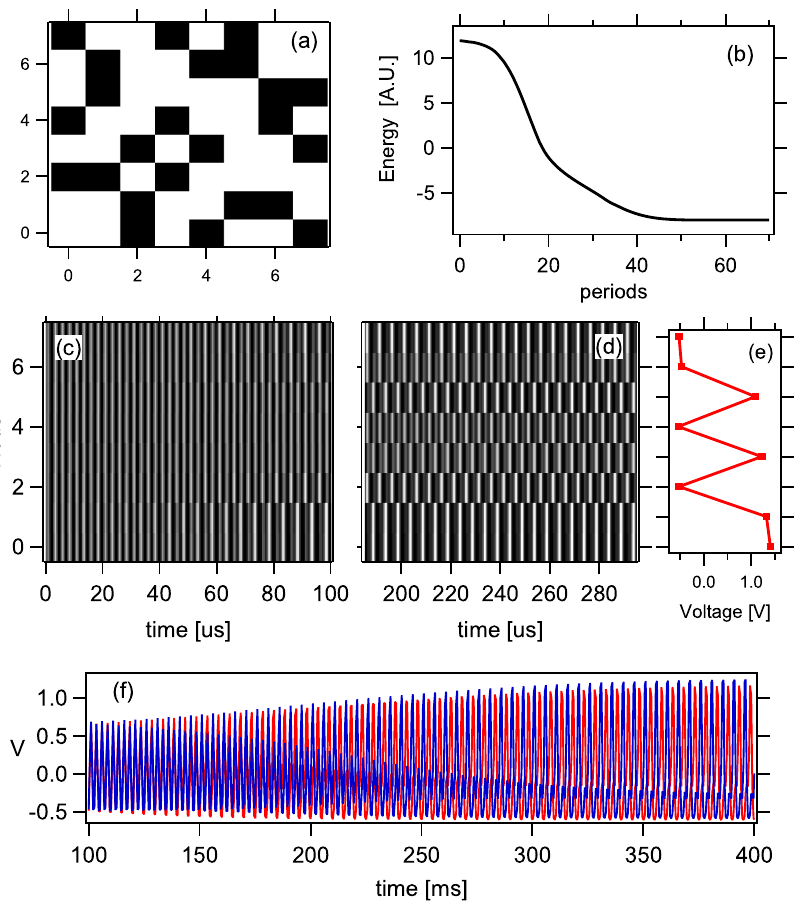
Fig. 5 Introducing additional network frustration. a Another 3-regular graph of N = 8. b Energy evolution of the network; we reach a ground state of energy E = − 8 after around 45 subharmonic periods. c , d Early and late circuit response, respectively. e The fi nal state, as encoded in the voltage pro fi le. f Time-evolution of the voltage at node 3 (red) and 4 (blue).